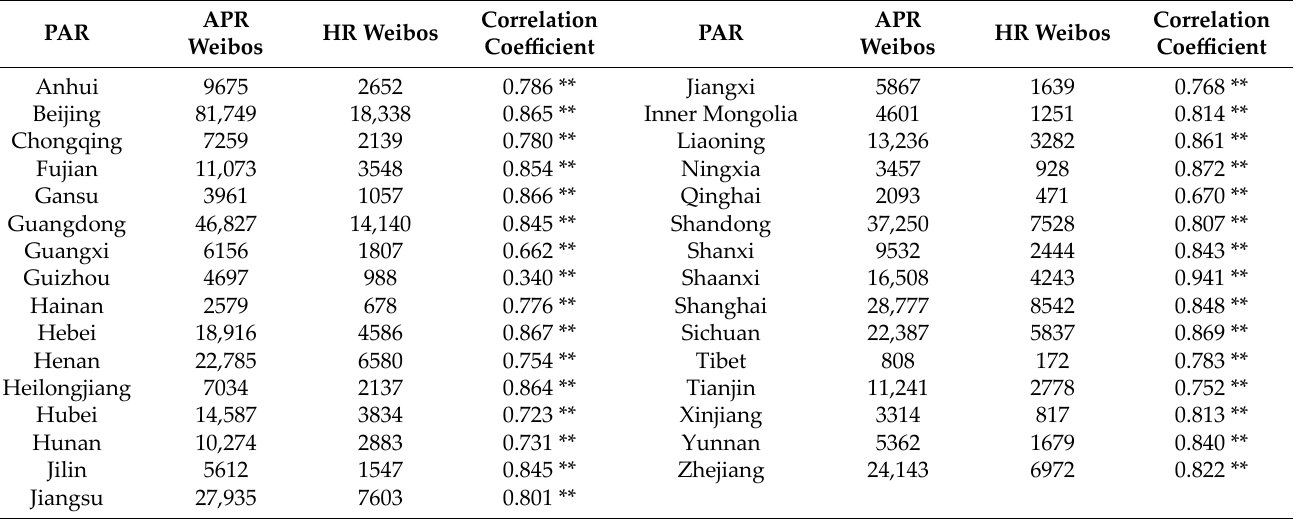
Table 2. Correlation coefficient between APR and HR Weibos in each PAR during